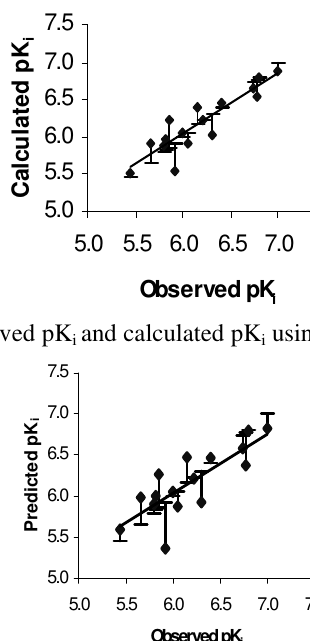
and predicted pK i